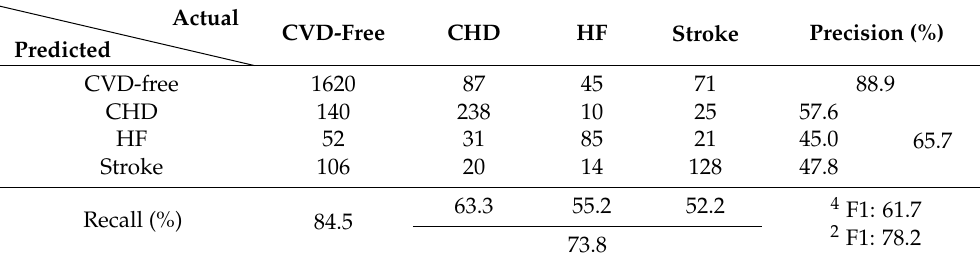
Table 2. The prediction results of incident CVD outcomes for the test set. Actual CVD-Free CHD HF Stroke Predicted